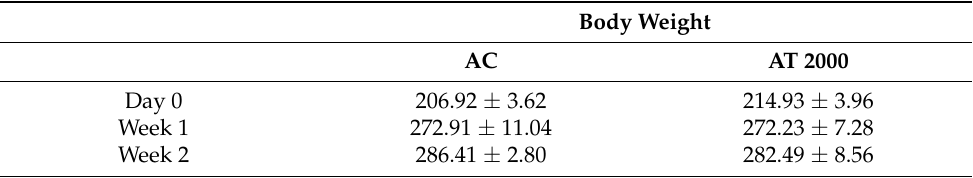
Table 2. Body weight in acute toxicity study. Values expressed as mean ± SEM.